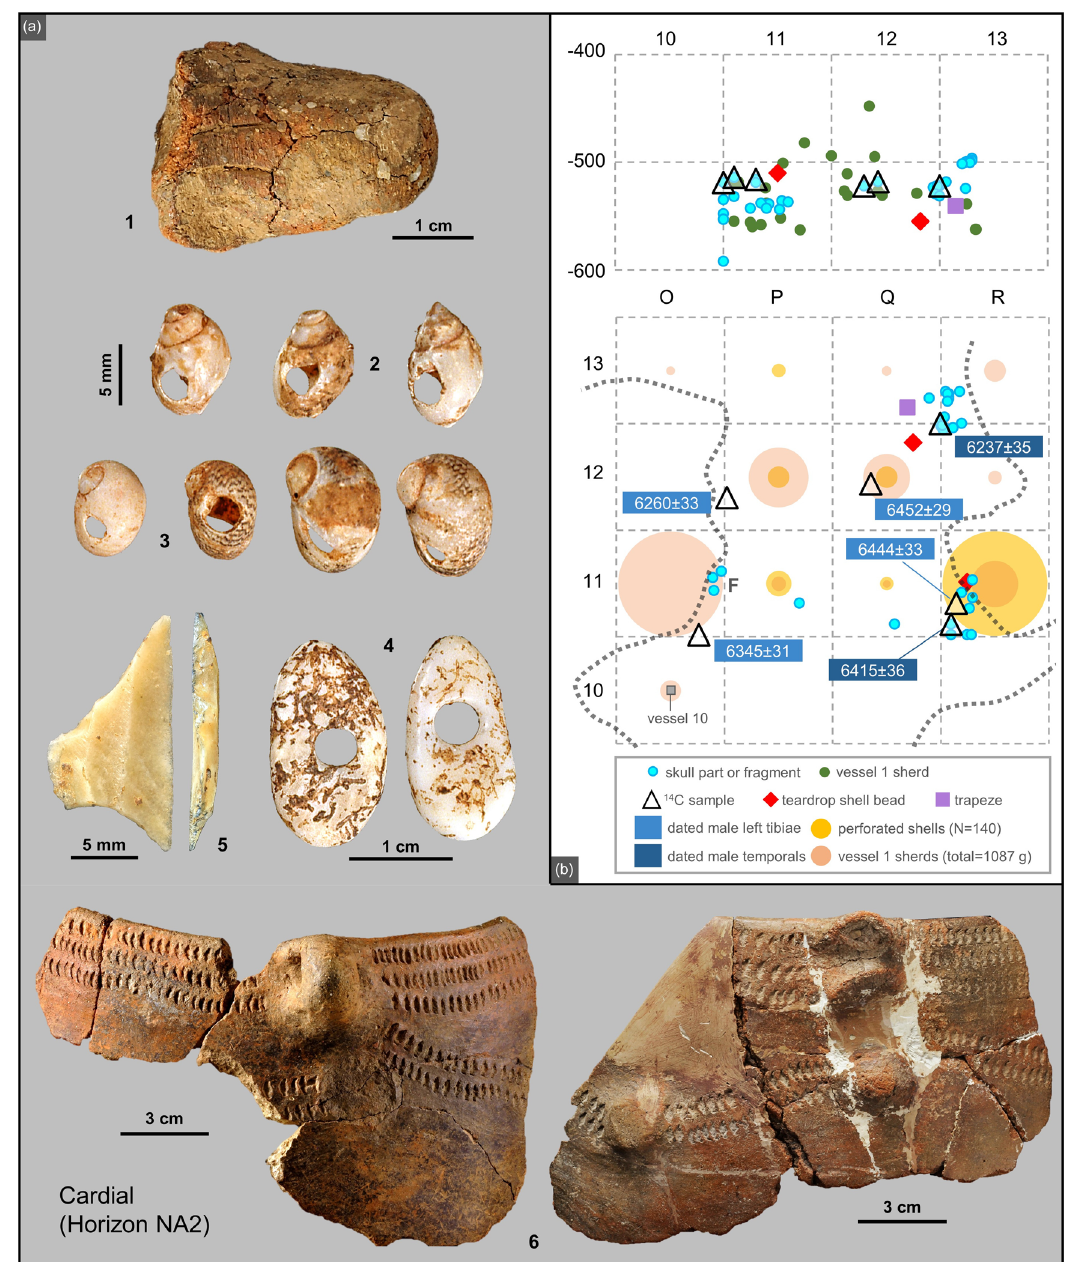
Figure 7: Gruta do Caldeirão. The Cardial context. ( a ) Artefacts from the NA2 horizon. 1. Vessel 10; 2. perforated Hynia pfei ff eri ; 3. perforated Theodoxus fl uviatilis ; 4. teardrop Glycymeris sp. beads; 5. fl int trapeze; and 6. two sets of conjoined sherds from Vessel 1. ( b ) Spatial distributions. Only the dated human bone samples providing the MNI have been plotted. The bubble graphs represent the distribution per square of Vessel 1 sherds ( by weight; total = 1,087 g ) and perforated gastropod shells ( by number; total = 140 ) . The position of the undated female mandible ( denoted by the letter F ) is indicated. The positions of the single Vessel 10 sherd in O10 and the teardrop bead in R11 are approximate. Note the similar elevation of the dated, large size skeletal remains ( corresponding to the surface of layer Eb, i.e. the cave fl oor atop which the bodies were laid down ) , and the signi fi cant vertical displacement of the smaller items. Elevations in cm below